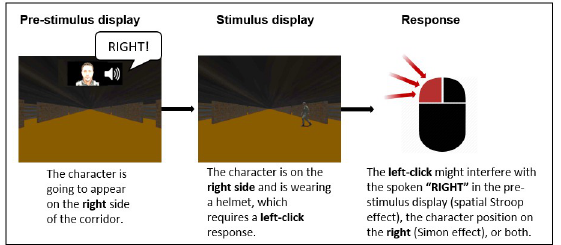
Fig 5. An example of Spatial Stroop and Simon effects in an “incongruent” AVC trial.